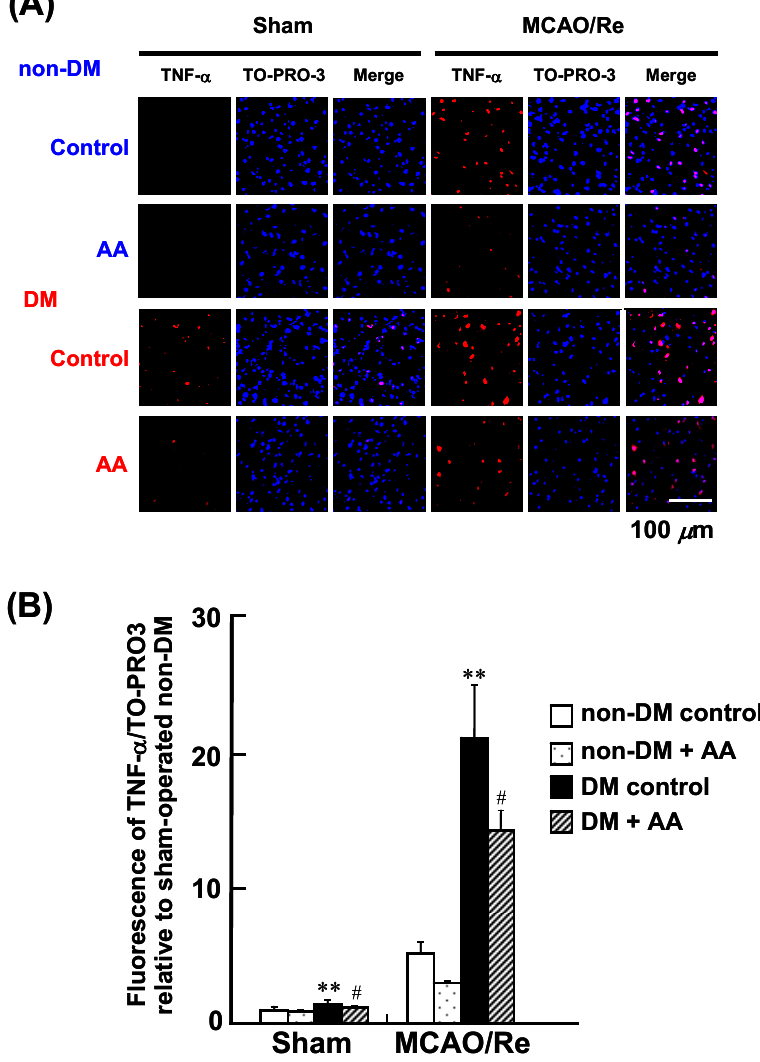
Figure 6. Effects of AA supplementation on expression of TNF- α in the penumbral cortex after MCAO/Re in the brain of nondiabetic and diabetic rats. ( A ) Representative photographs of TNF- α immunostaining (red fluorescence) and staining of nuclei by TOPRO-3 (blue fluorescence) in the cortex coronal sections of nondiabetic and diabetic rats; ( B ) Quantitative analysis of TNF- α fluorescence intensity in the cortex. The data are presented as mean ± SD ( n = 3–4). ** p < 0.01 compared with the nondiabetic control group. # p < 0.05 compared with the diabetic control group. DM in the figure denotes diabetic, while non-DM denotes